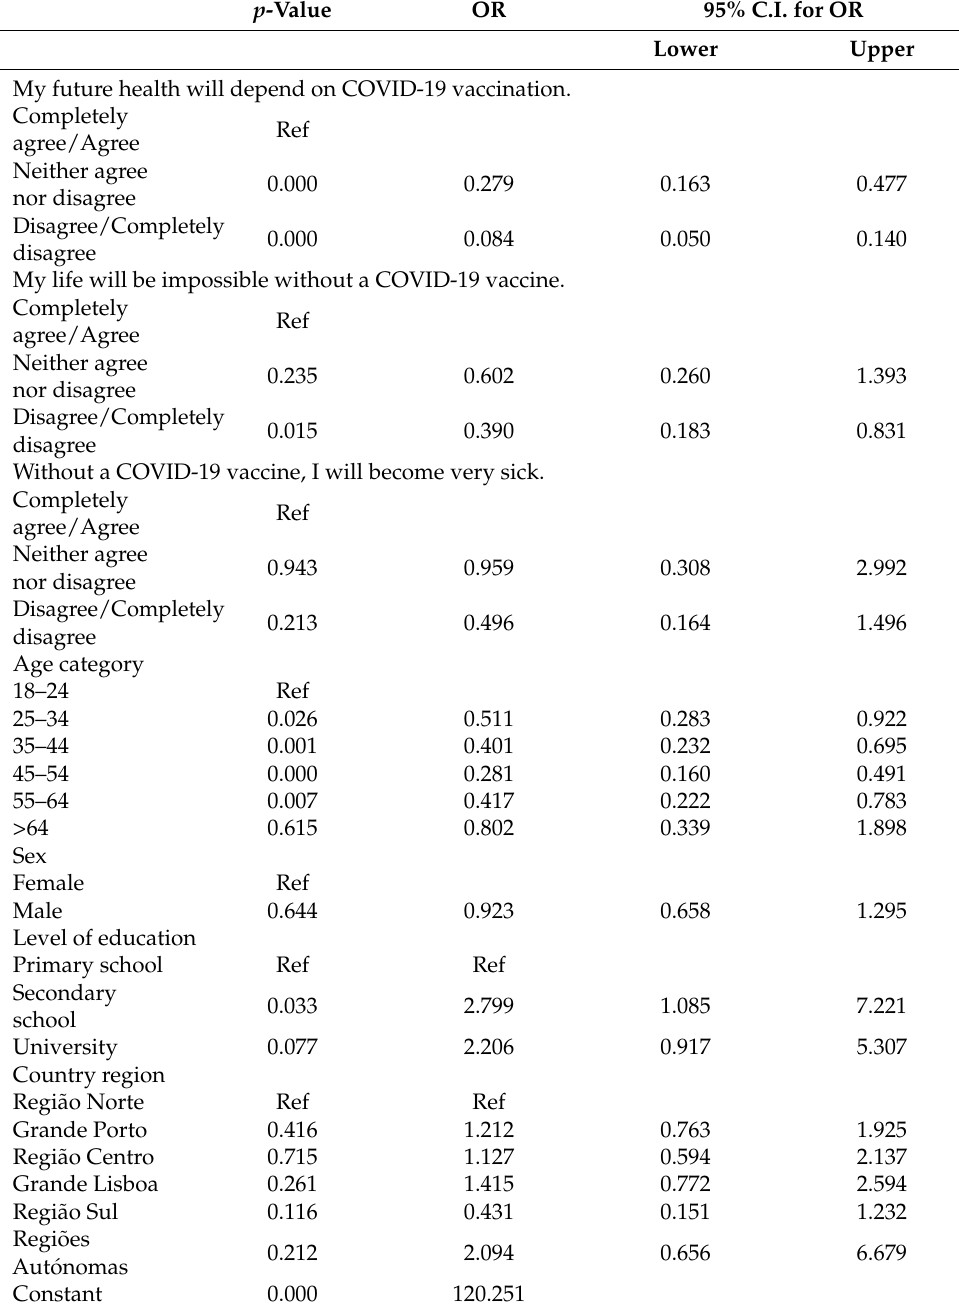
Table 5. Perceived vaccine necessity and vaccine